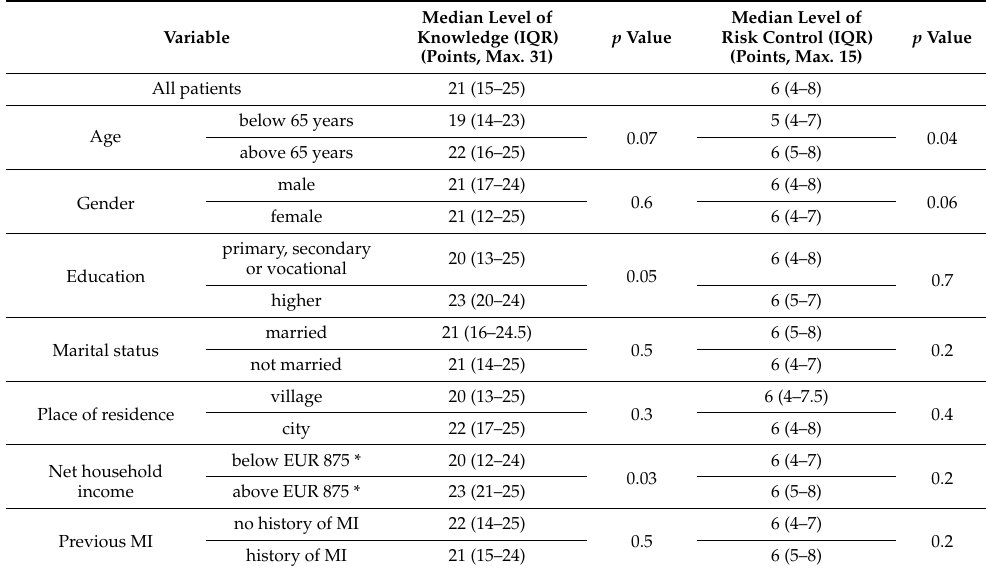
Table 4. Impact of factors other than a history of PCI or CABG on the level of knowledge and the level of coronary artery disease risk control—independent analysis.